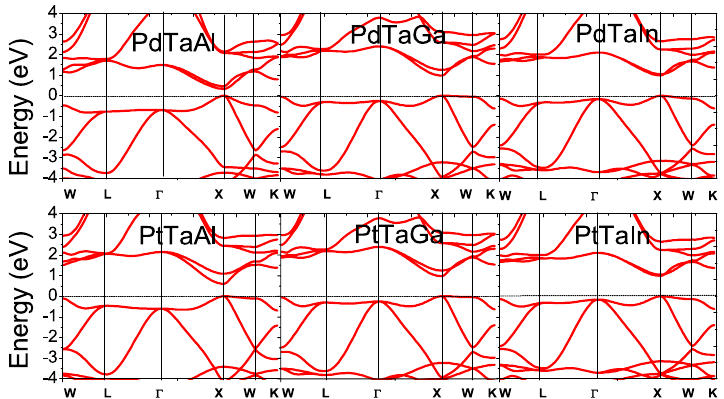
Figure 3. Electronic structure of XTaZ alloys with Fermi level set at zero.